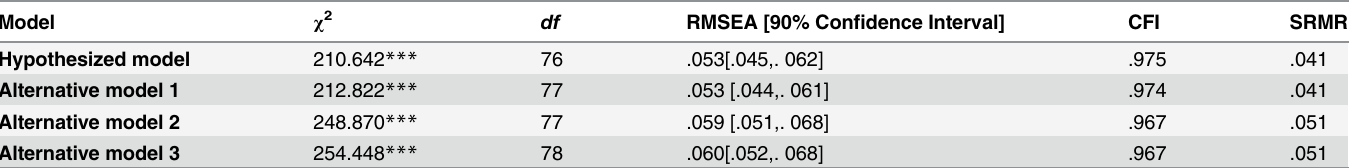
Table 2. Fit indices of the hypothesized and alternative